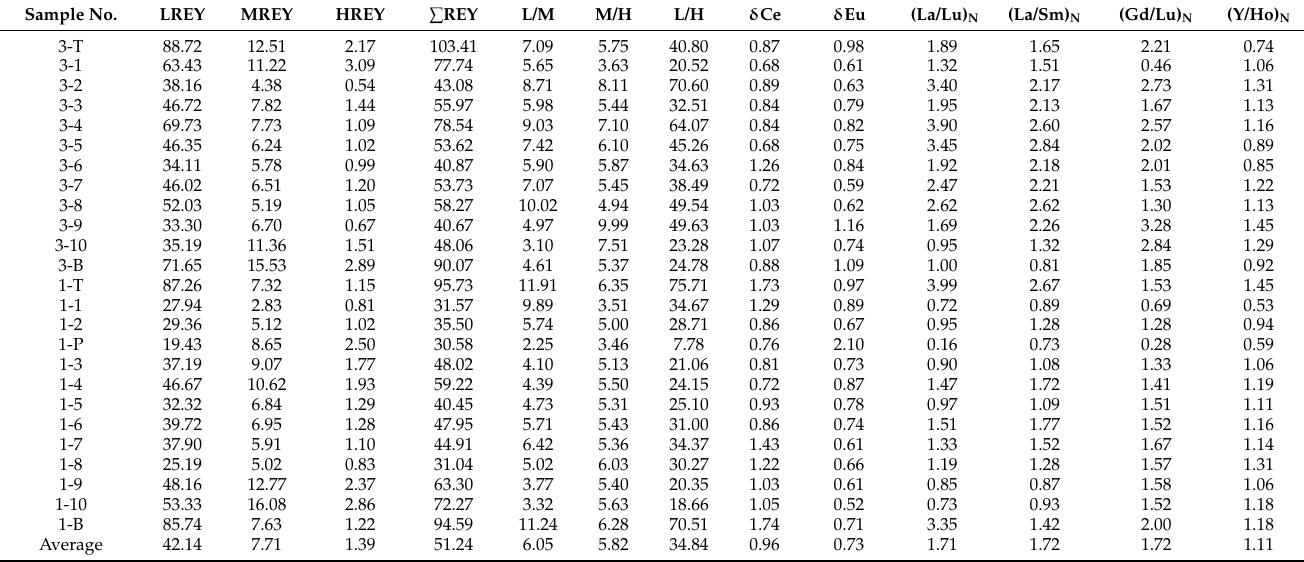
Table 6. Geochemical parameters of rare-earth elements in the Shanxi Formation coal seam from the Huainan